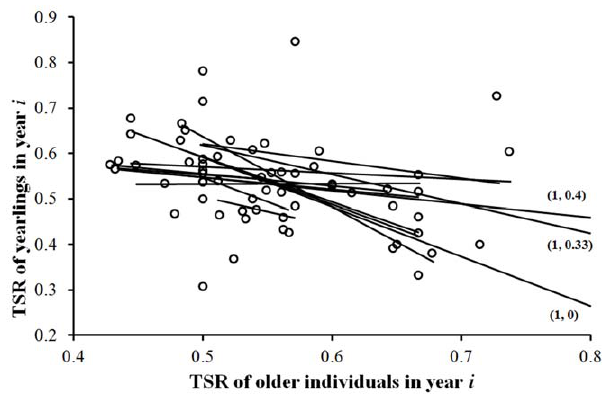
Figure 2. Yearlings TSR in relation to older individuals TSR recorded in the same year in 67 years 6 colony events. Continuous lines are least squares regressions for the 14 colonies included in the sample. Three data points with sex ratio of older individuals=1 are not represented to better visualize the other data points. The coordinates ( x , y ) of those points are in parentheses.